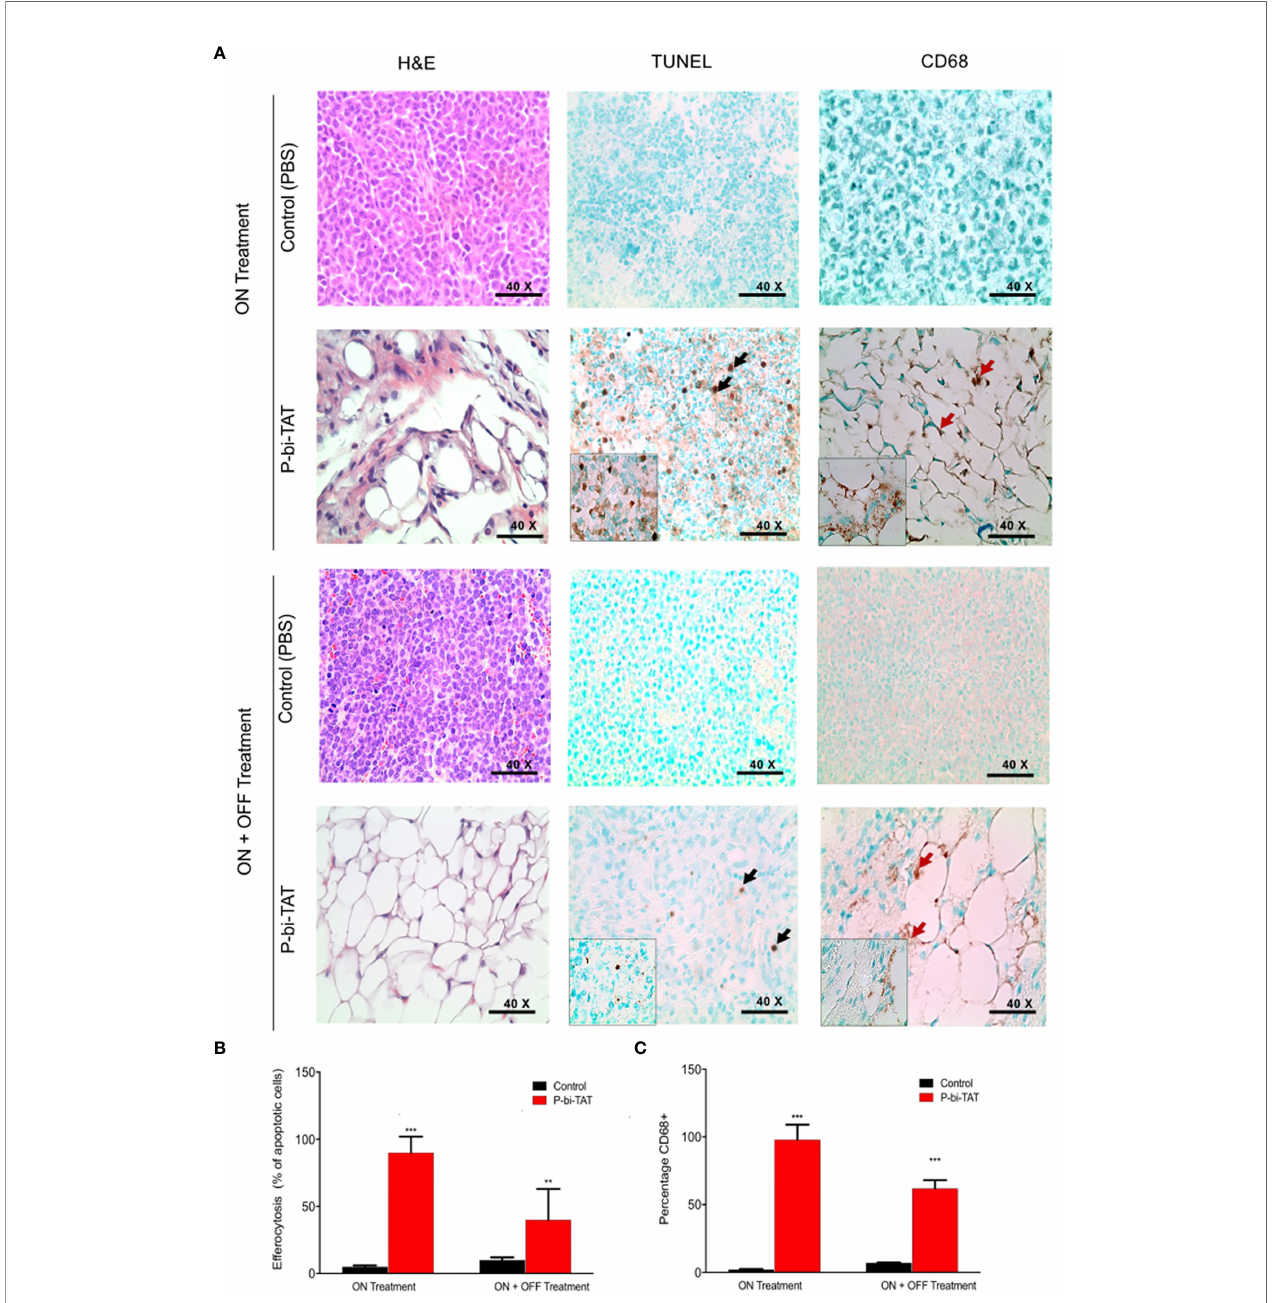
FIGURE 2 | Histopathological evaluation of samples of U87-luc xenografts from nude mice after treatment with P-bi-TAT. Tumor sections were subjected stained to H&E staining, TUNEL assay, and CD68 immunohistochemical staining for each group. Tumor samples were obtained after 21 days of treatment with subcutaneous injection of either PBS and P-bi-TAT (10 mg/kg body weight) (ON treatment) OR an additional 21 days after discontinuation of treatment (ON + OFF treatment model). (A) Representative images of H&E staining, TUNEL assay, and CD68 staining are presented. Black arrows indicate apoptotic cells and red arrows indicate macrophages. Scale bar 40 X, insert 100 X. (B) Percentage of apoptosis of tumor tissues in control and P-bi-TAT was measured with the TUNEL assay. (C) Percentage of CD68 positive cells per view in control and P-bi-TAT. Values are expressed as percentage of mean ± SD, ***P < 0.0001, **P <